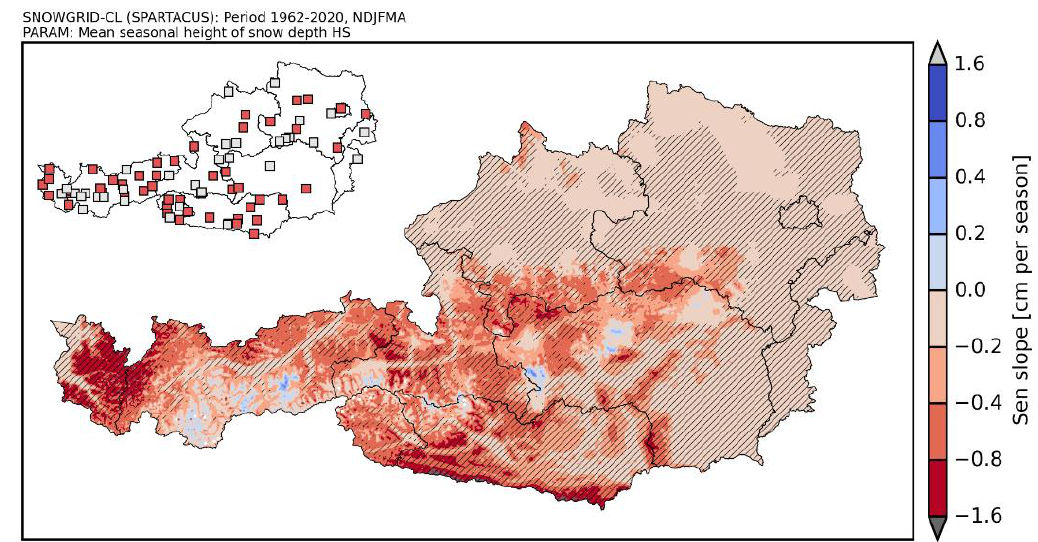
Figure 7. SG-CL calculated trend map of mean seasonal HS (NDJFMA) changes in the period 1961/62–2019/20, hatched areas indicate significant trends (at a 95% confidence level ( p < 0.05)). Observed trends for the same period (SNOWPAT dataset) are shown as a small insert map.